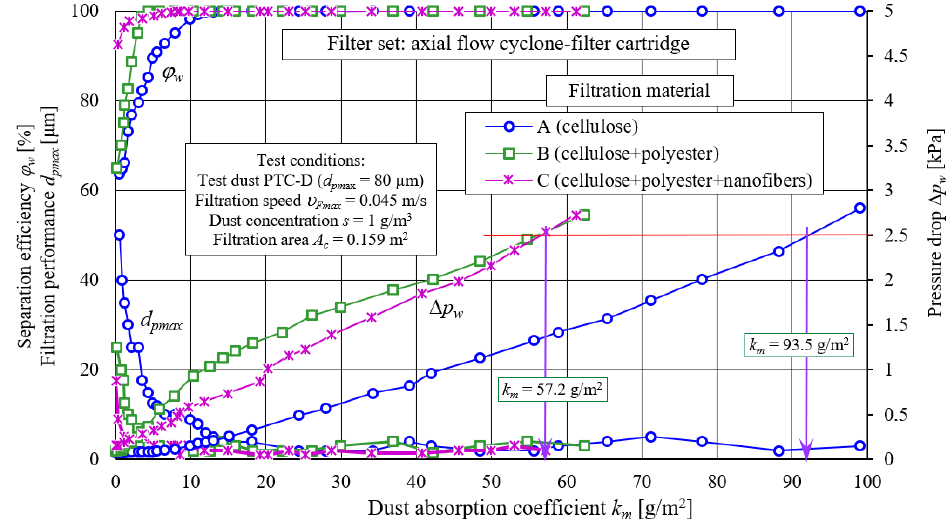
Figure 17. Characteristics: separation efficiency φ w = f ( k m ), filtration performance d pmax = f ( k m ) and pressure drop Δ p w = f ( k m ) as a function of dust absorption coefficient k m of filter materials A, B and C tested in “filtration set” as the second filtration stage after axial flow cyclone.